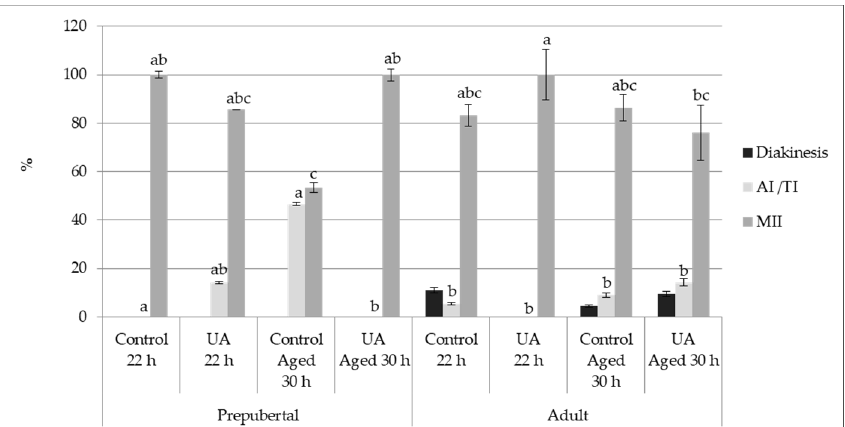
Figure 2. Effect of the Urolithin A (UA) supplementation to the maturation medium, cumulus-oocyte-complexes (COCs) aging and female age on the oocyte chromosomal configuration (prepubertal: control 22 h, UA 22 h, control aged 30 h, UA aged 30 h; adult: control 22 h, UA 22 h, control aged 30 h, UA aged 30 h groups). Different letters indicate significant differences between groups for the same stage (AI/TI, Anaphase-I/Telophase-I; MII, Metaphase-II) ( p ≤ 0.05).